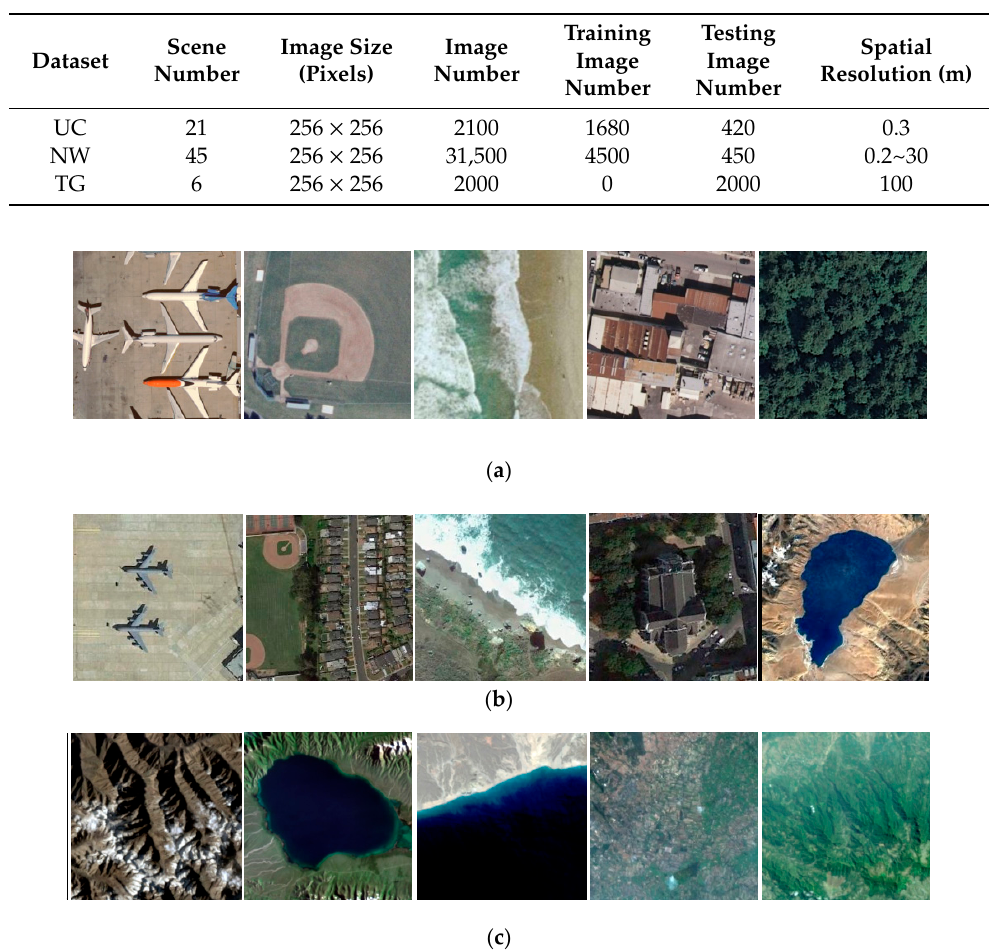
Figure 5. Example images of three datasets: ( a ) UC dataset, ( b ) NW dataset, ( c ) TG dataset.